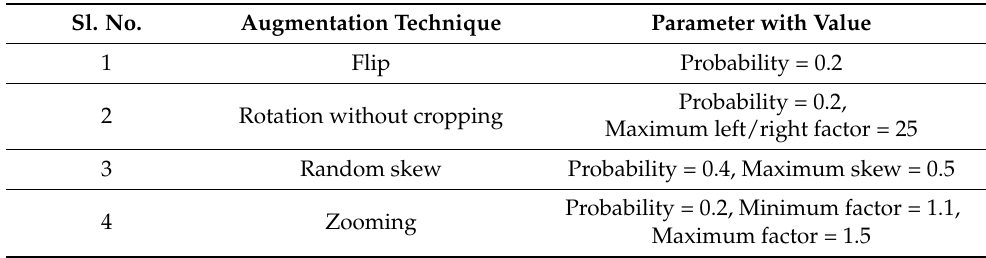
Table 2. Parameters of the augmentation techniques applied in the current study. Sl.